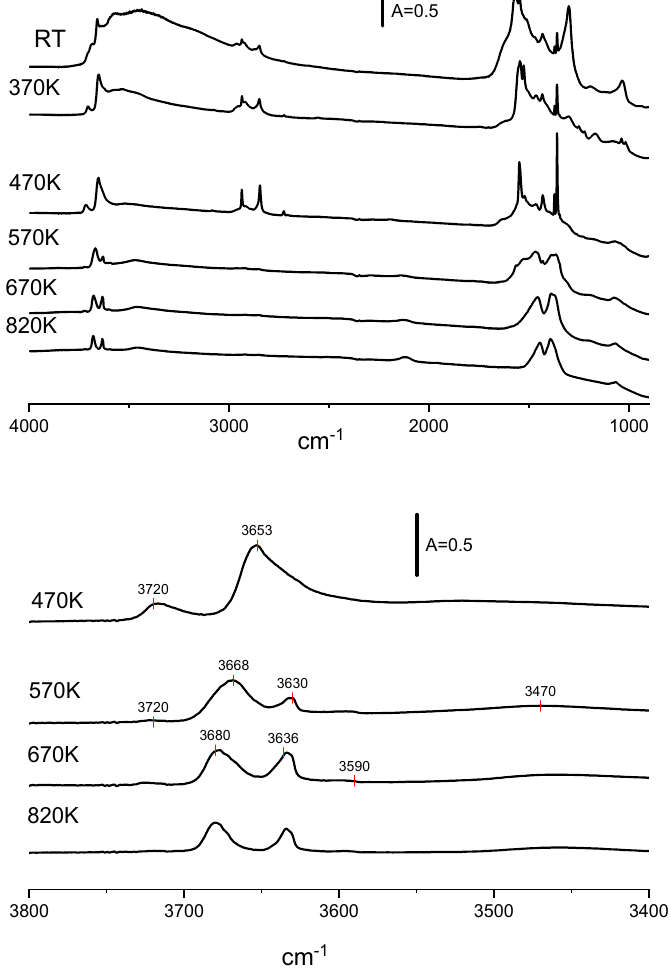
Figure 2. The spectra of OH groups on CeO 2 activated in a vacuum at various temperatures. The spectra of OH groups also change upon evacuation at high temperatures. Two distinct bands are present upon evacuation at 470 K. According to Jacobs et al. [12], they may be assigned to OH (I) (3720 cm − 1 ) and to OH (II) (3653 cm − 1 ). The last band is broad and most probably it is composed of several submaxima. At a temperature of 570 K and higher, the OH (II) band splits as well as the OH (II A) 3668 cm − 1 and OH (II B 3630 cm − 1 ) bands. A weak OH (III) band at 3590 cm − 1 is also present. The analysis of the OH (II A) band shows that it is composed of two submaxima around 3680 and 3668 cm − 1 . The hydroxyls at 3668 cm − 1 are more prone to dihydroxylation and they disappear upon calcination at 670 K. Two distinct bands of OH (IIA) and OH (IIB) at 3680 and 3636 cm − 1 , respectively, are clearly seen upon activation at 820 K, together with weak bands of OH (I) and OH (III) at 3720 and 3590 cm − 1 . The broad and very weak band around 3470 cm − 1 was attributed to an oxyhydroxy species [31,35].